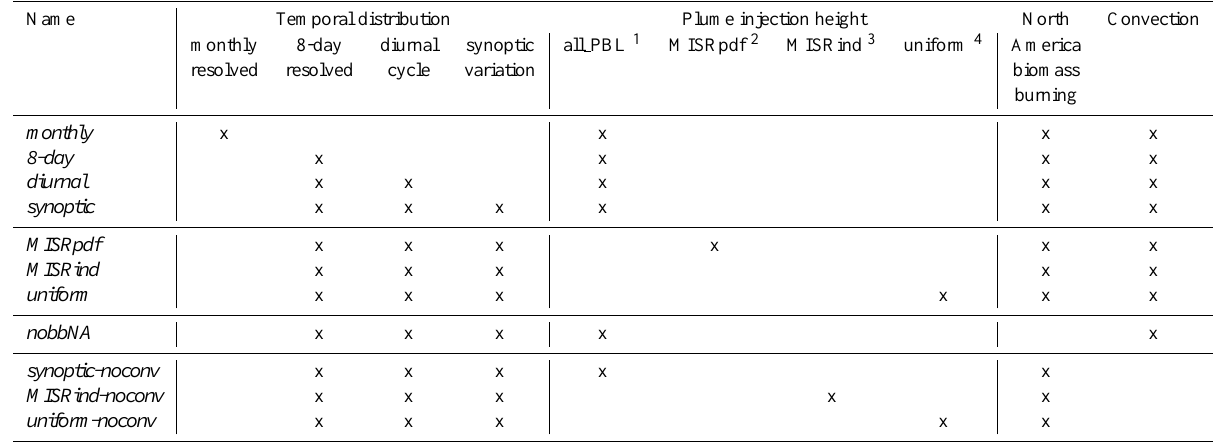
Table 1. GEOS-Chem simulations with different GFEDv2 biomass burning emission inventories (different temporal distributions and plume injection heights) and with or without